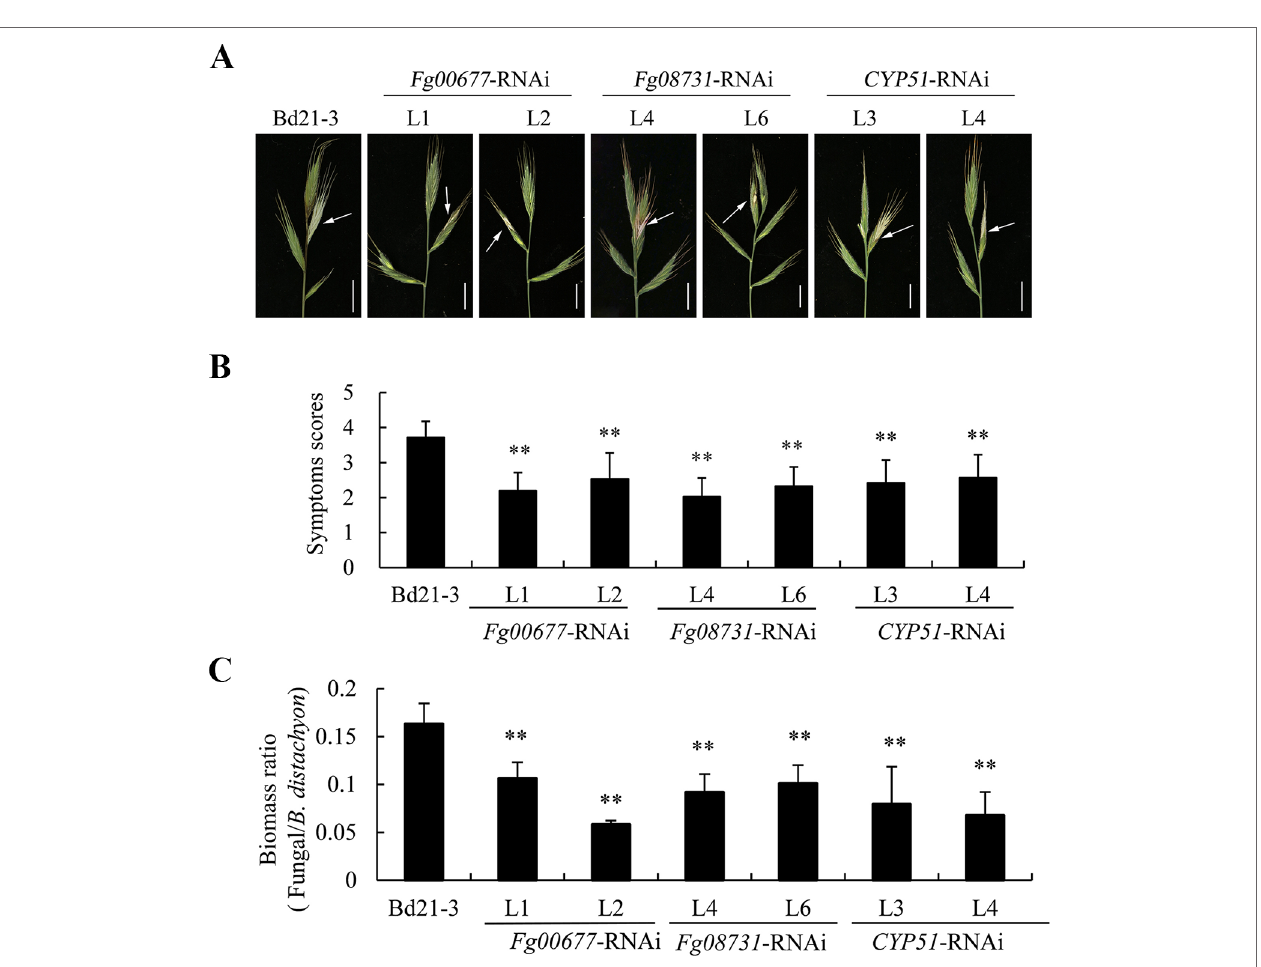
FIGURE 6 | Evaluation of disease resistance of T2 transgenic B. distachyon lines with Fg00677 -RNAi, Fg08731 -RNAi, and CYP51 -RNAi constructs against F. graminearum . (a) The second spikelet from the top of the spike of transgenic B. distachyon lines and non-transgenic controls was point inoculated with F. graminearum PH-1 strain and photographed at 9 dpi. Bar, 1 cm. Arrows indicate the inoculation site. (B) Quantification of the disease symptoms using a scoring scale at 9 dpi. Values represent the means ± standard deviation of at least 30 plants. Similar results were obtained from three biological replicates. (C) F. graminearum and B. distachyon biomass ratio measured via total DNA content at 5 dpi by absolute quantification using the internal reference genes beta- tubulin and BdUBC18 , respectively. Values represent the means ± standard deviation of three biological replicates. Differences were assessed using Student’s t tests. Double asterisks indicate P <